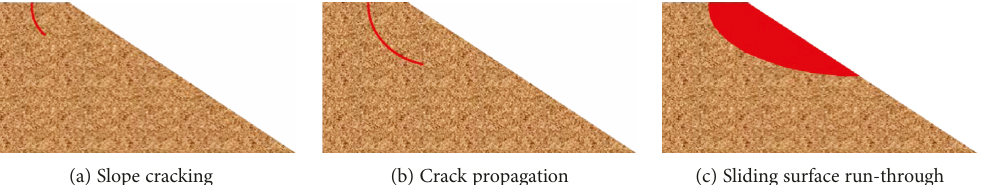
Figure 16: Slope instability process.